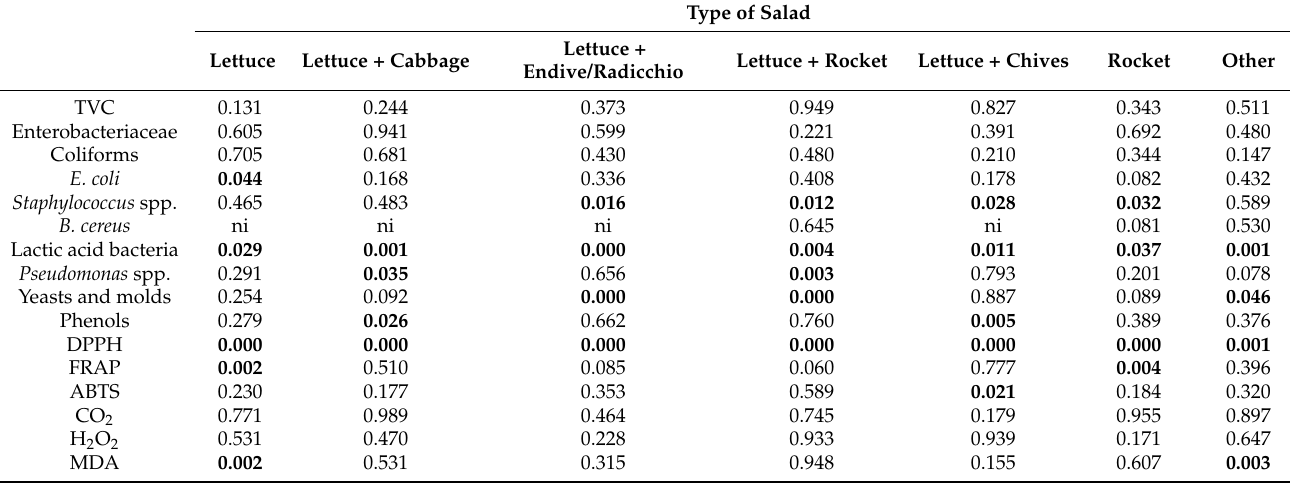
Results shown are the p values following independent samples t -test, and bold values suggest significant differences ( p < 5%). Other = lettuce + 2 or more ingredients. ni = the correlation and t -test could not be computed because the standard error of the difference was